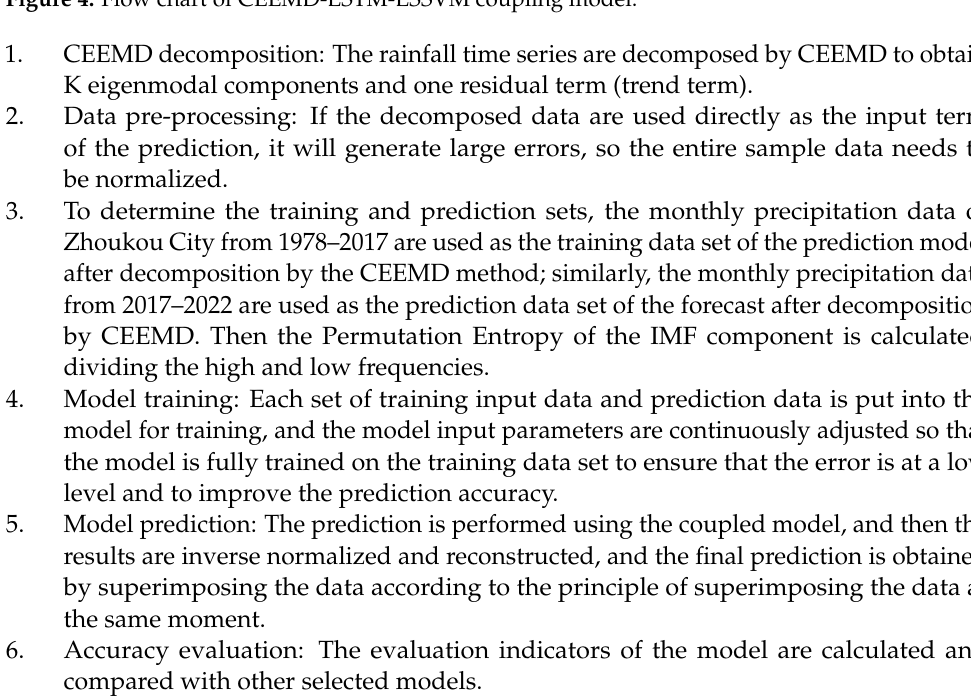
Figure 4. Flow chart of CEEMD-LSTM-LSSVM coupling model.